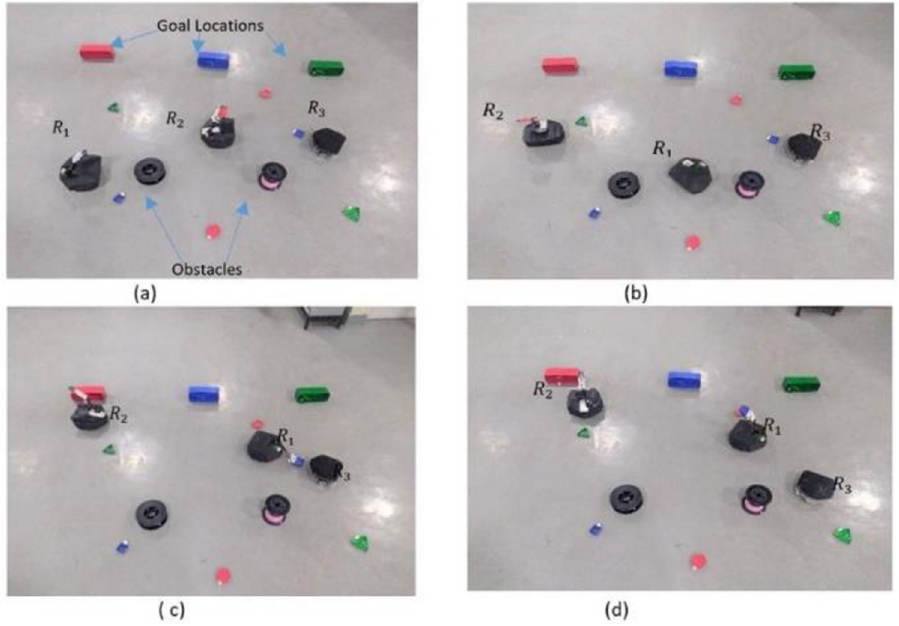
Fig 9. Real Experimentation (a) Robotic arm absence in R 3 (b) Resource sharing request received by R 1 and R 2 (c) Lowest Bid of R 1 accepted by R 3 (d) Task completion by R 1